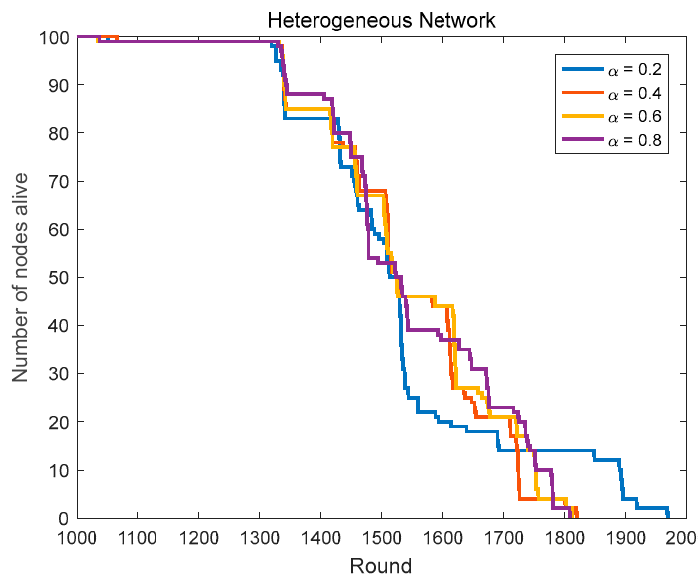
Figure 12. The network lifetime comparison in heterogeneous networks (routing factor = 0.2, 0.4, 0.6 and 0.8).